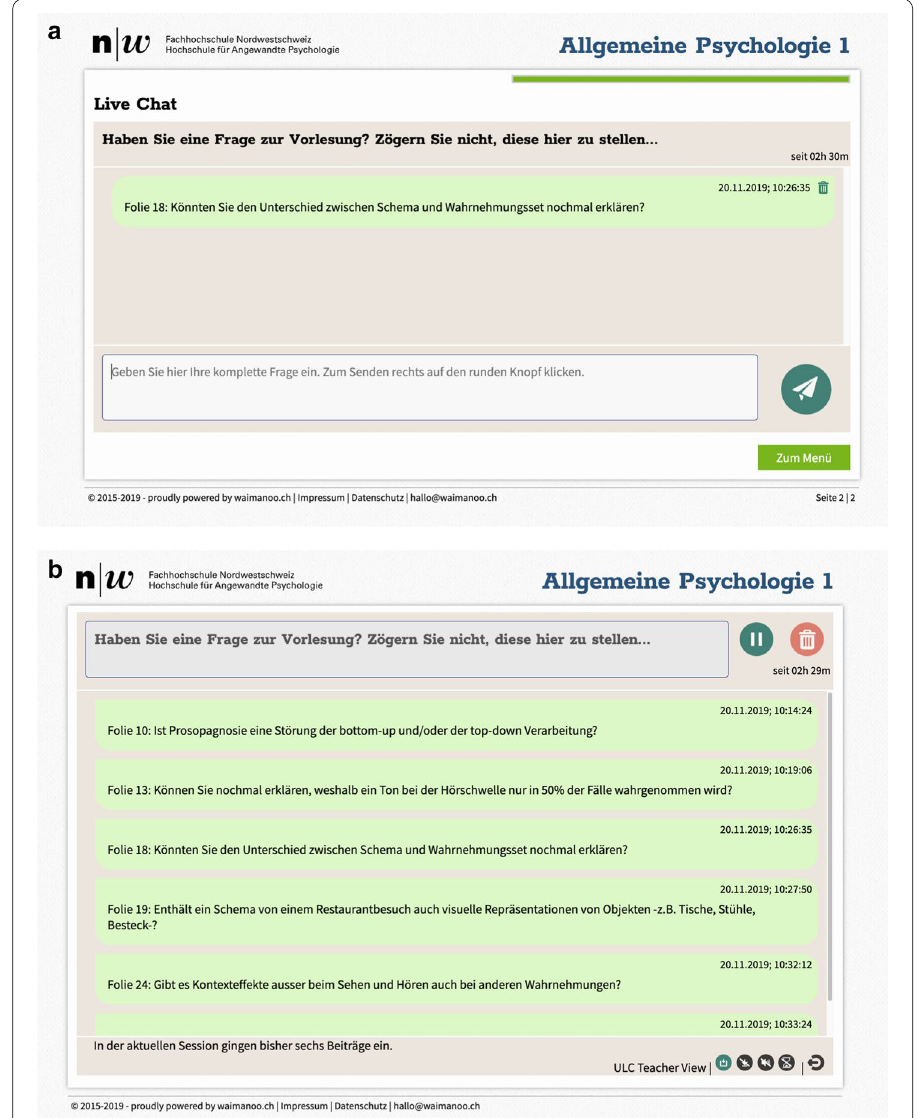
Fig. 1 a Students’ view of the CC for asking questions anonymously during lectures. The task (to ask questions) is displayed at the top of the screen and the students can write their questions in the box at the bottom of the screen. b Lecturer view for reviewing questions during breaks and showing these to the students after